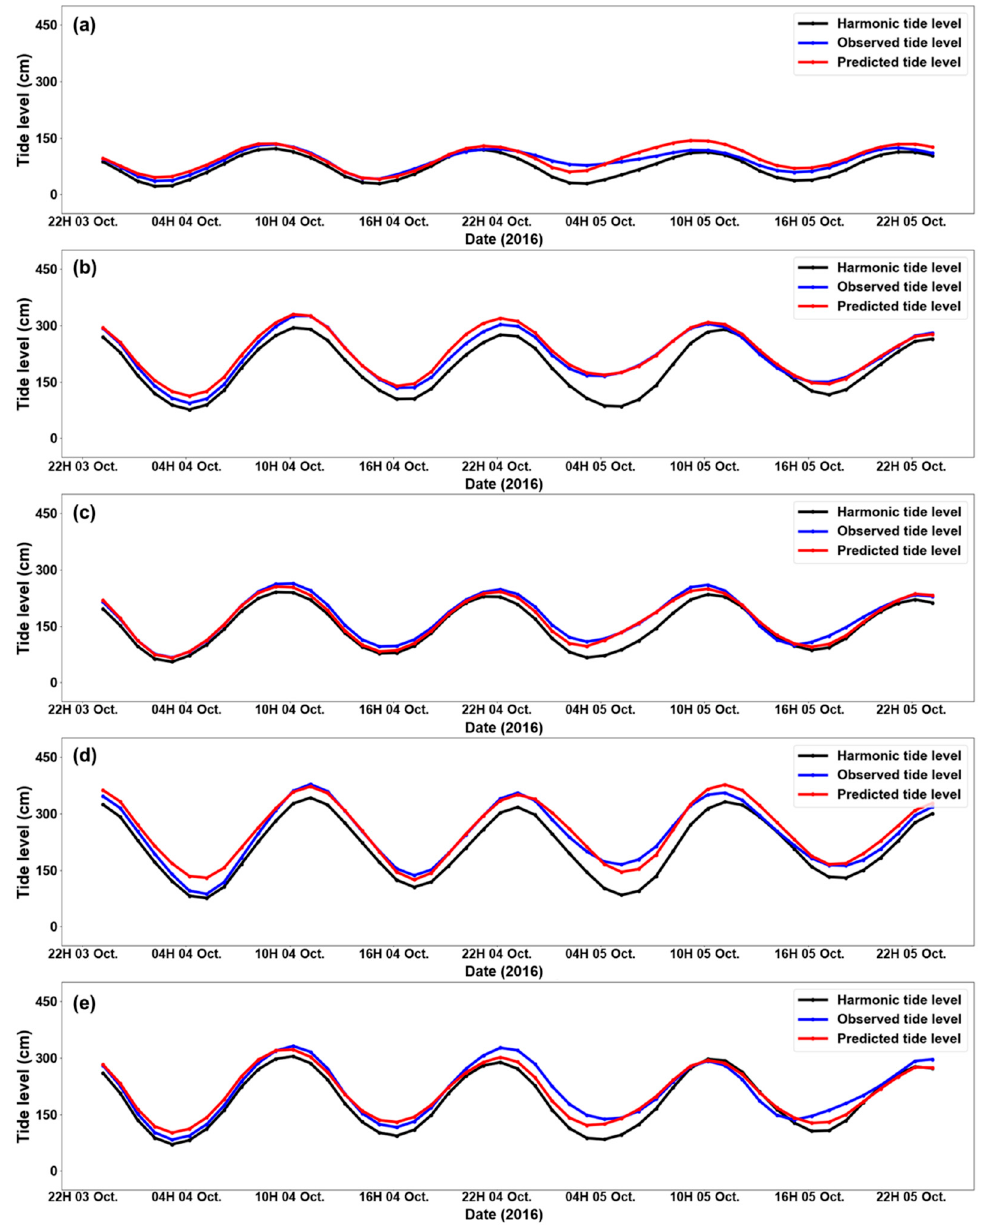
Figure 16. Validation of trained model during Typhoon Chaba (2016). Time-series results for ( a ) Busan, ( b ) Geomundo, ( c ) Tongyeong, ( d ) Wando, and ( e ) Yeosu stations. Red lines are results predicted by the trained model. Blue and black lines show observed and harmonic tide levels, respectively, at the tidal station.